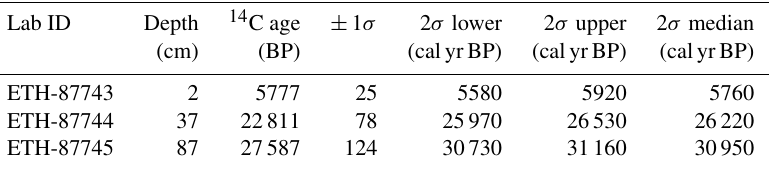
Table 1. Radiocarbon ages of epibenthic foraminifera (species selected: Lobatula lobatula , Cibicides refulgens , and Discanomalina coro- nata ). Ages are corrected for a reservoir age of 390 ± 80 years (Siani et al., 2000).